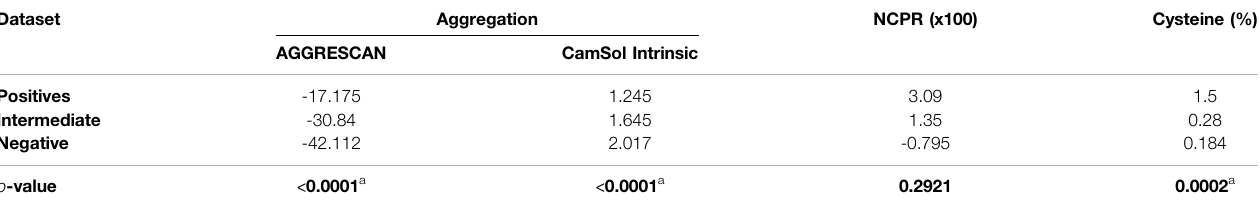
TABLE1| Meanvaluesforaggregation, NCPR,andcysteinepercentage box-plotsinpositive,intermediate,andnegativedatasetsrepresentedin Figure1 p -valuesforthe differences between the positive and negative PrLDs subsets are shown.